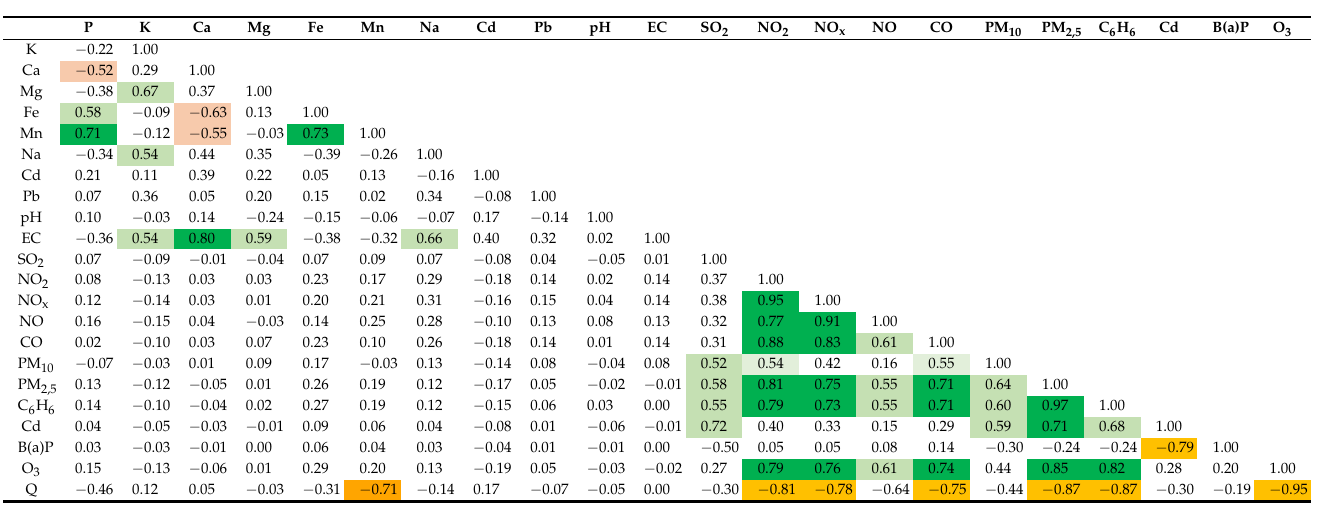
Table 7. Pearson’s correlation for all tested variables (the level of correlation was determined based on the Guilford classification).